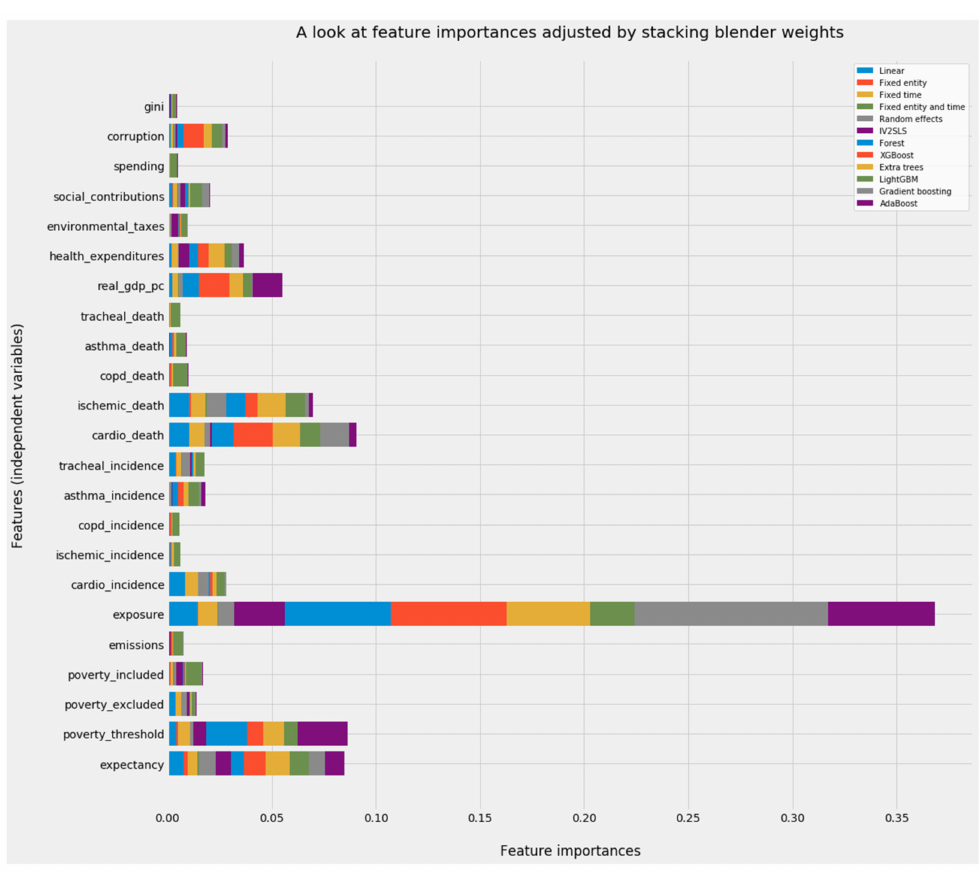
Figure 7. Aggregated feature importances for all predictive models and the entire PM 2.5